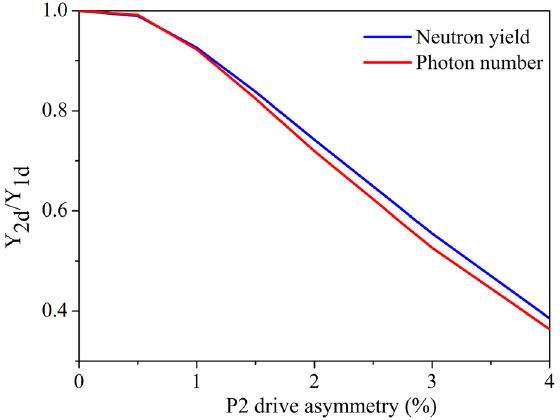
Figure 7. (Color online) Horizontal axis is P2 drive asymmetry of the radiation source on the capsule. Vertical axis is the ratio of the 2D calculation results to the 1D calculation results. Black curve shows the DD-fusion neutron yield variation according to the P2 drive asymmetry, and red curve shows number of 8 ± 0.39-keV photons emitted by hotspot according to P2 drive asymmetry.